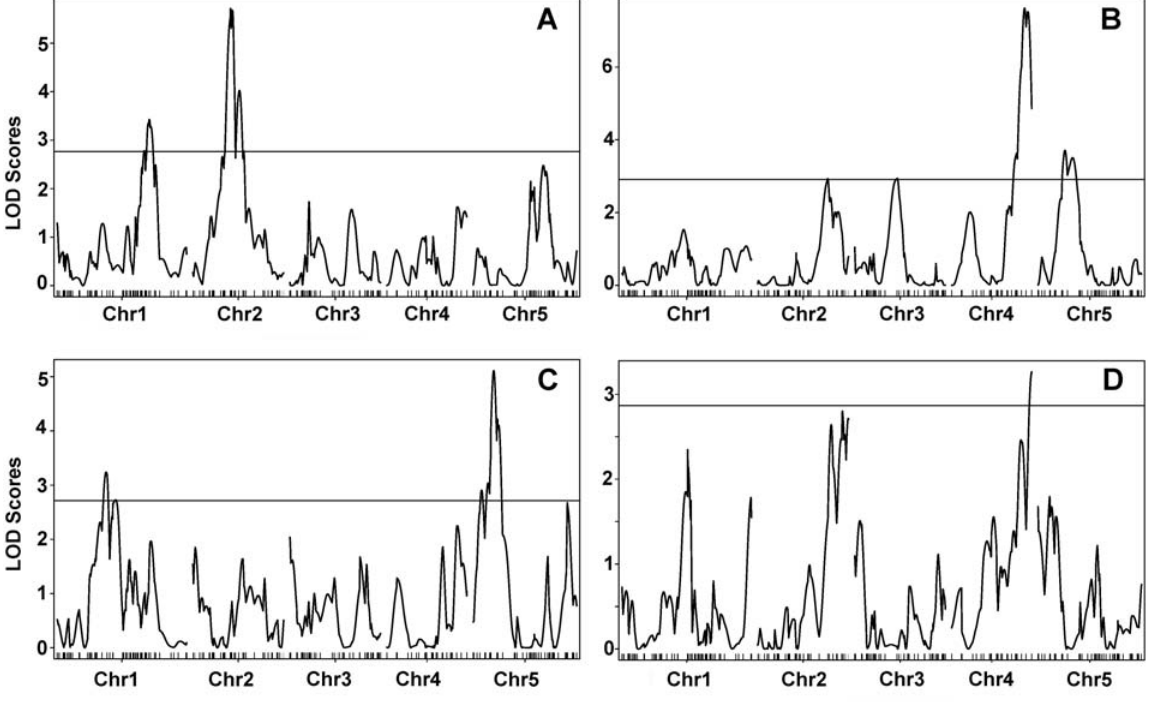
Figure 5. QTL analysis of hypocotyl elongation using EstC AI-RILs. QTL maps for red (A), blue (B), white (C), and far-red (D) are shown. Significant LOD scores were determined by permutation testing and are indicated by horizontal lines.